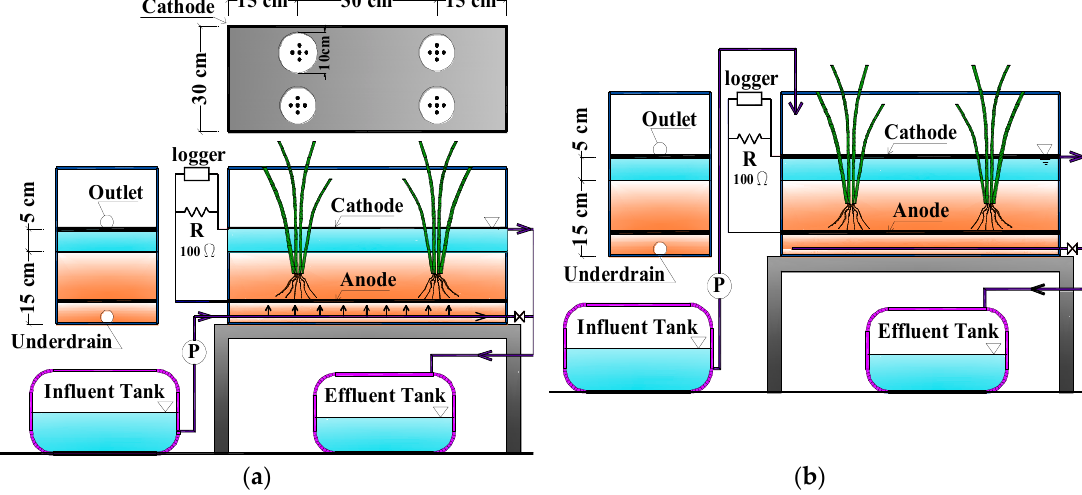
Figure 1. Simulated paddy fields with different directions of continuous treated municipal wastewater (TWW) irrigation: ( a ) Bottom-to-top irrigation; and ( b ) top-to-top irrigation.